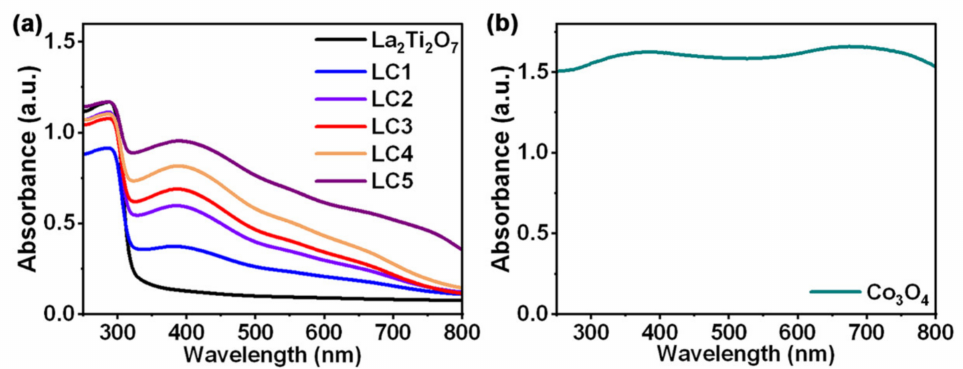
Figure 7. ( a ) UV-Vis absorption spectra of La 2 Ti 2 O 7 and composites; ( b ) UV-Vis absorption spectrum of Co 3 O 4